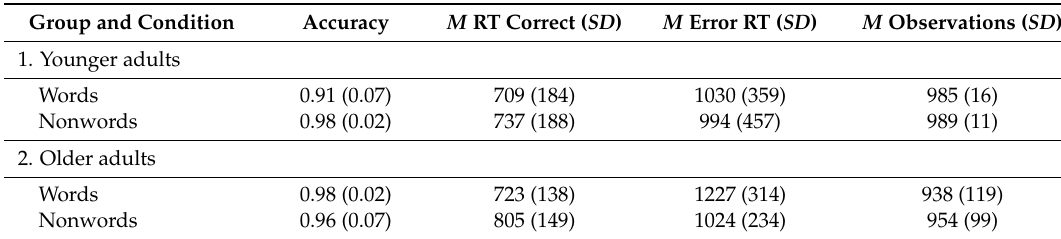
Table 2. Summary of reaction times (RT) and accuracy